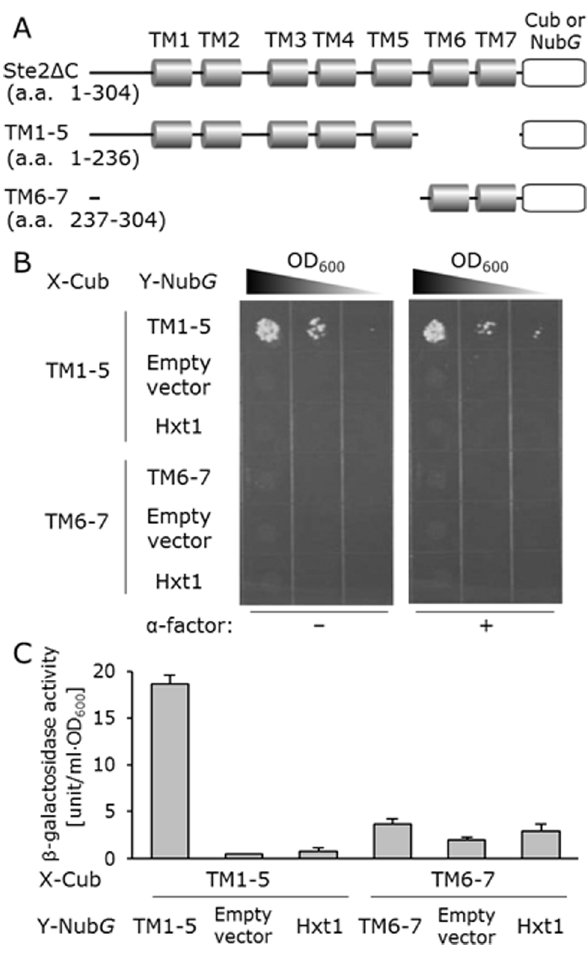
Figure 4. Detection for dimerization of yeast Ste2p deletion mutants (TM1–5 and TM6–7) in NMY62 strain. (A) Schematic of Ste2 D C and the deletion mutants. Transmembrane (TM) domains are indicated with pillar-type boxes, and the Cub (Cub-LexA-VP16) or Nub G (Nub with I13G mutation) is depicted as a rounded rectangle. (B) Growth assay without a -factor ( left panels ) and with 5 m M a -factor ( right panels ). Each cell was spotted in serial 10-fold dilutions on SD –Leu, Trp, Ade and His dropout plate. (C) Quantitative b -galactosidase activity in yeast cells containing various combinations of plasmids. Error bars represent the standard deviations ( n= 3). The control prey plasmids were pPR3-C mock vector (empty vector) and pPR3-HXT1.